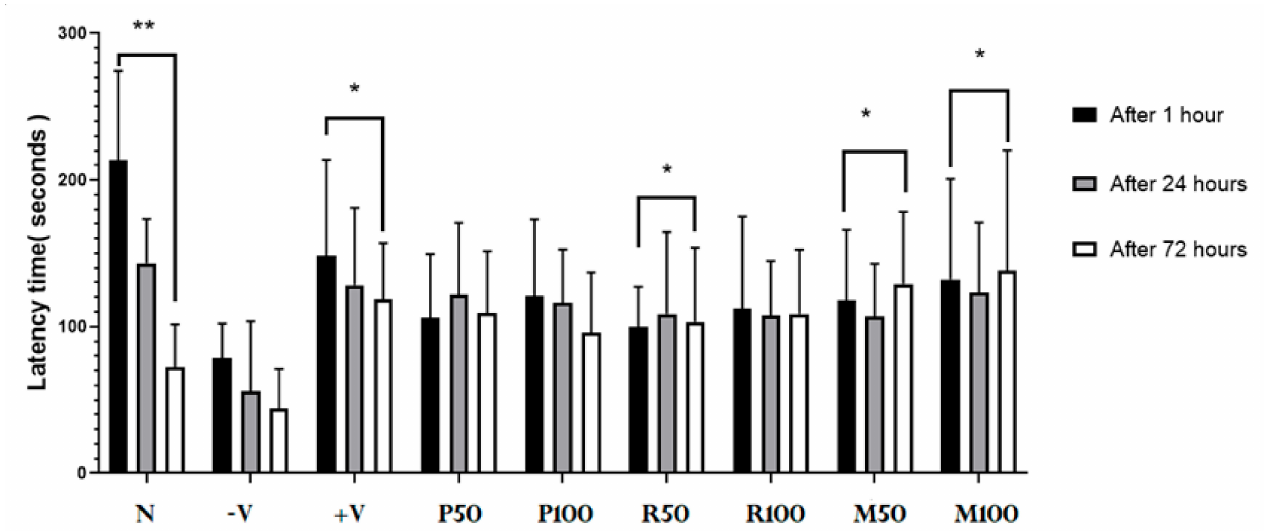
Figure 5. Therapeutic PA test results. Each rat was subjected individually to the PA test (after 1 h, 24 h and 72 h from the time of last electrical foot shock). The time needed to enter the dark room was recorded as PA transition latency time (in seconds; y-axis). Data are presented as mean ± standard deviation (SD), n = 6 and the statistical analysis was performed by one-way ANOVA followed by Tukey’s post-hoc test, * p < 0.05, ** p < 0.01. Comparison was within the groups (between 1, 24, and 72 h for each group). P = peppermint oil extract; R = rosemary oil extract; N = Normal; − V = negative; +V = positive; PR = both peppermint oil and rosemary oil extracts in which M50 means: 25 + 25 mg of each oil extract, while M100 means 50 + 50 mg of both